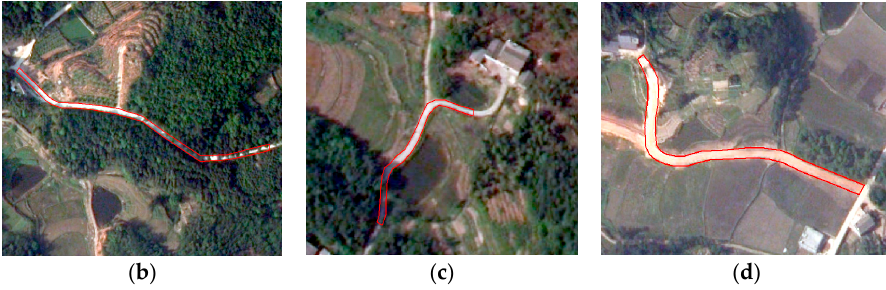
Figure 9. Sample road segments of the study area. ( a ) spatial distribution of all sample roads, ( b ) Sample road 1, ( c ) Sample road 2, ( d ) Sample road 3.